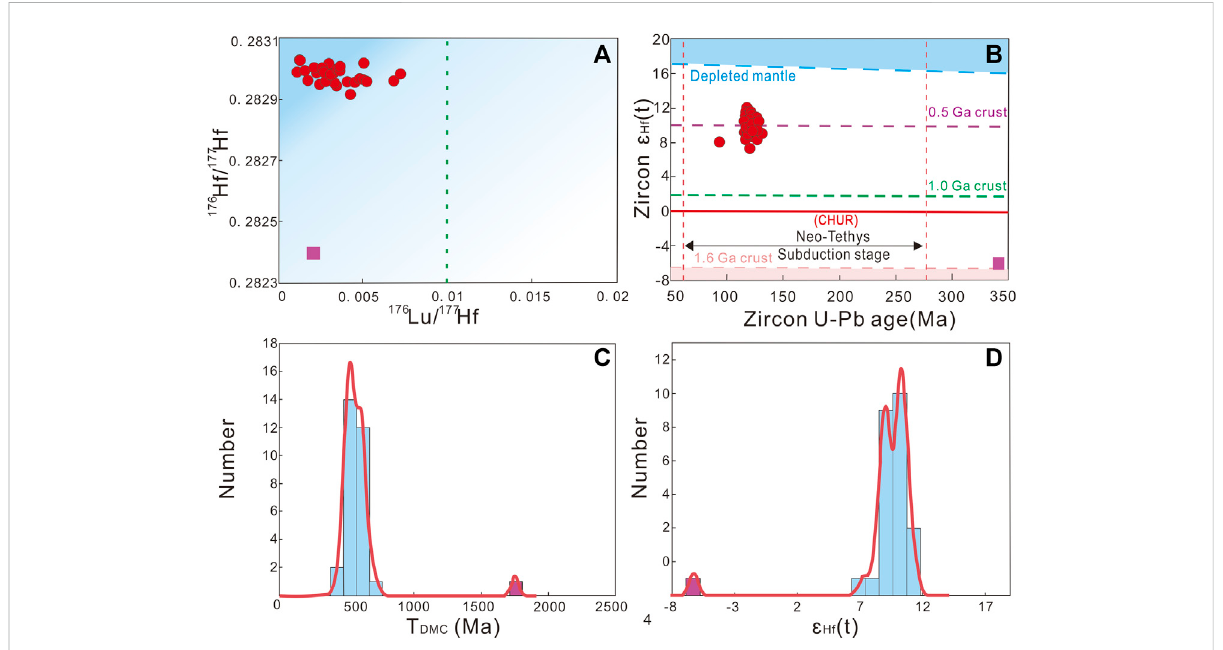
FIGURE 7 ZirconLu-Hfisotoperesults (A) 176 Lu/ 177 Hfvs. 176 Hf/ 177 Hfdiagram. (B) ZirconU-Pbagevs. ε Hf(t)diagram. (C) Histogramofthemodelage(T DMC ). (D) Histogram of ε Hf(t)